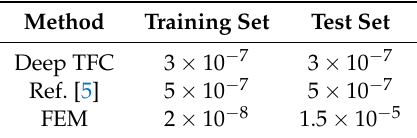
Table 1. Comparison of Deep TFC, Ref. [5], and finite element method